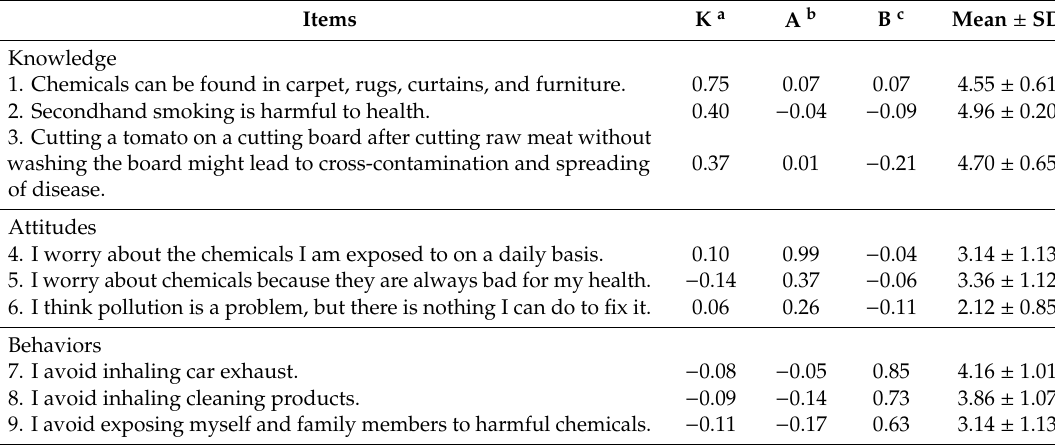
Table 7. Exploratory factor analysis results for the General environmental health